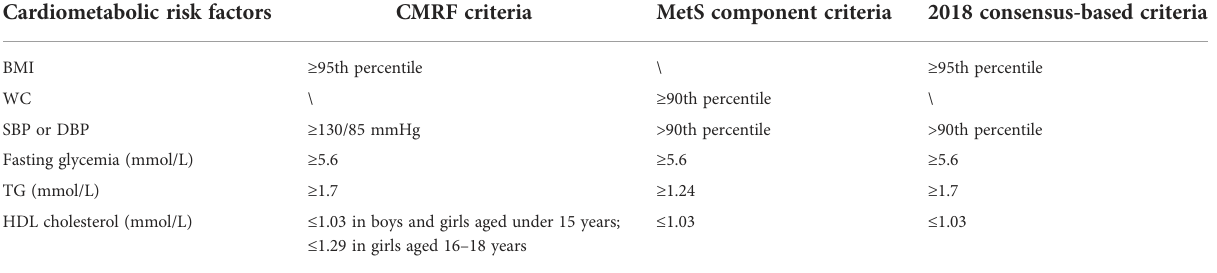
TABLE 1 Detailed cutoff values of each component in three MHO